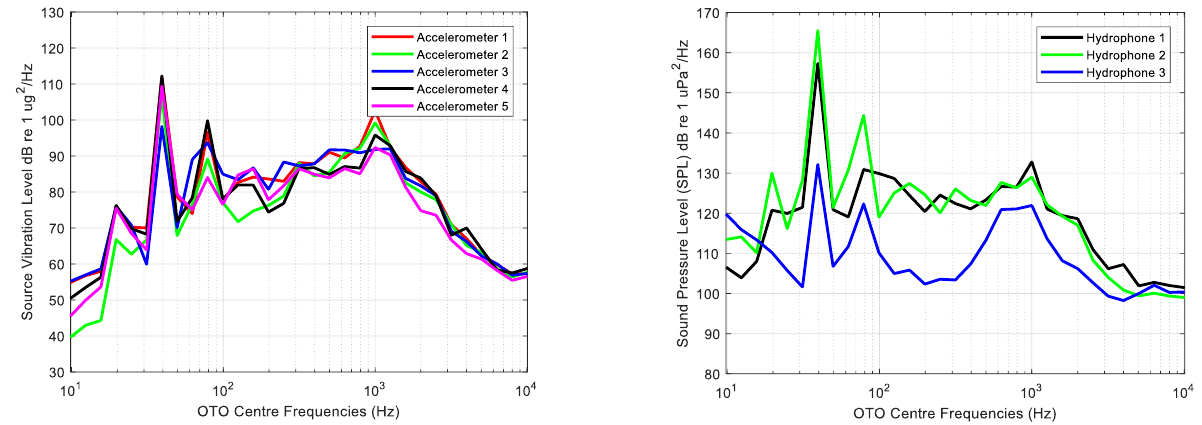
Figure 6. Average of each one third octave processed for all measurements with the main engine started for each accelerometer ( left ) and each hydrophone ( right ).